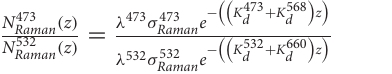
Blue Green multichannel RS multichannel RS [de Lima Ribeiro et